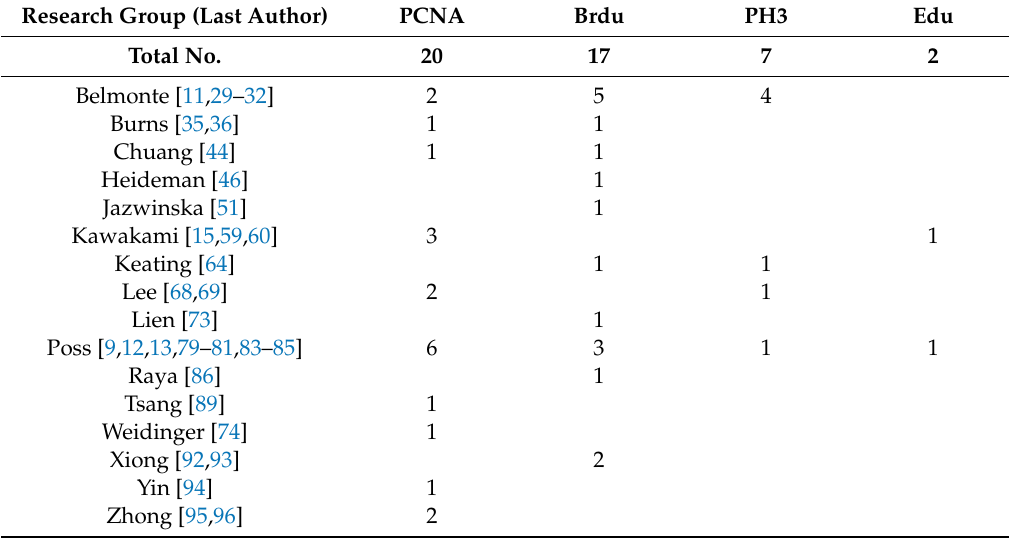
Table 3. Proliferation markers used to quantify cardiomyocyte proliferation after apex resection (AR) in zebrafish.